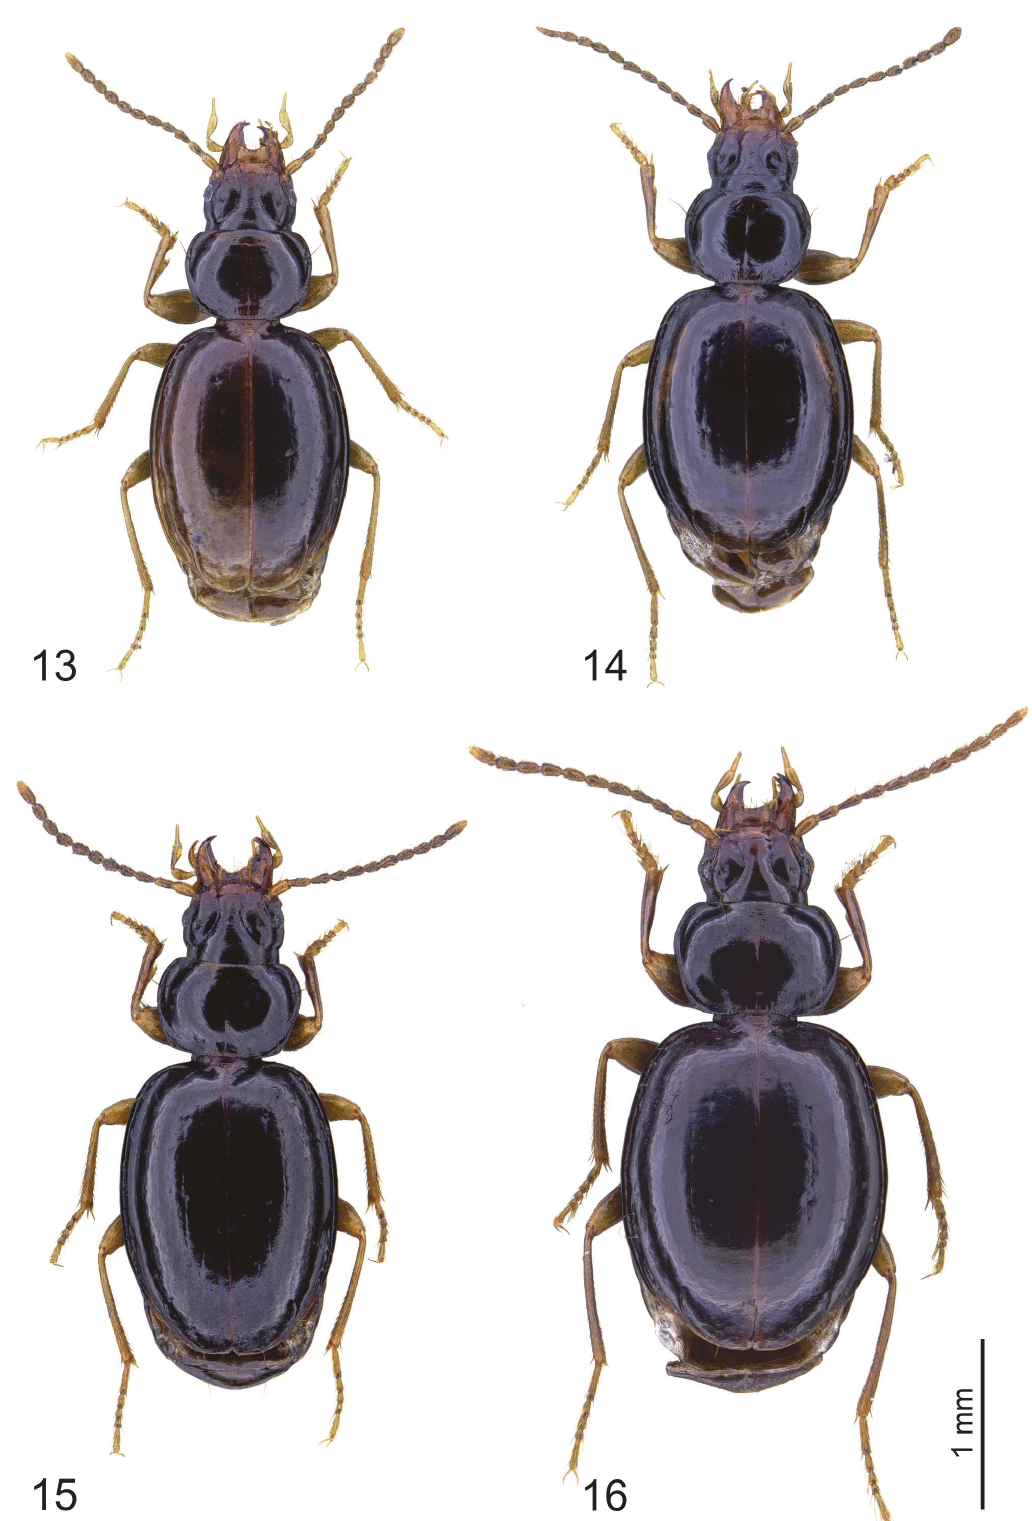
Figs 13–16. Trechus spp., habitus. 13 . T. rira sp. nov., holotype. 14 . T. iridescens sp. nov., holotype. 15 . T. oppositus sp. nov., paratype, ♂. 16 . T. bombi sp. nov.,